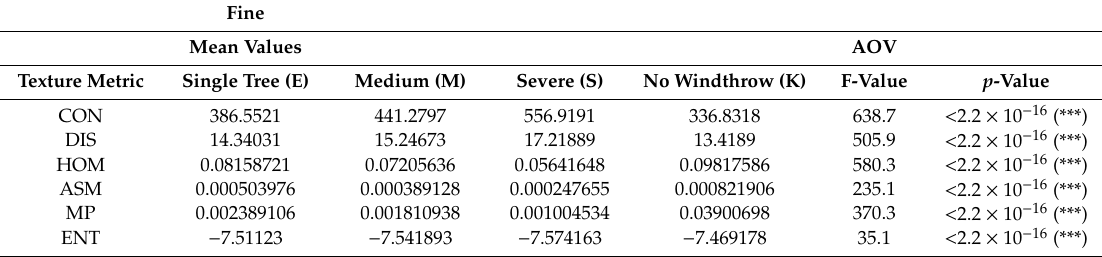
Table 6. Mean values and diagnostic values for an analysis of variance for the texture metrics in the “fine” group.